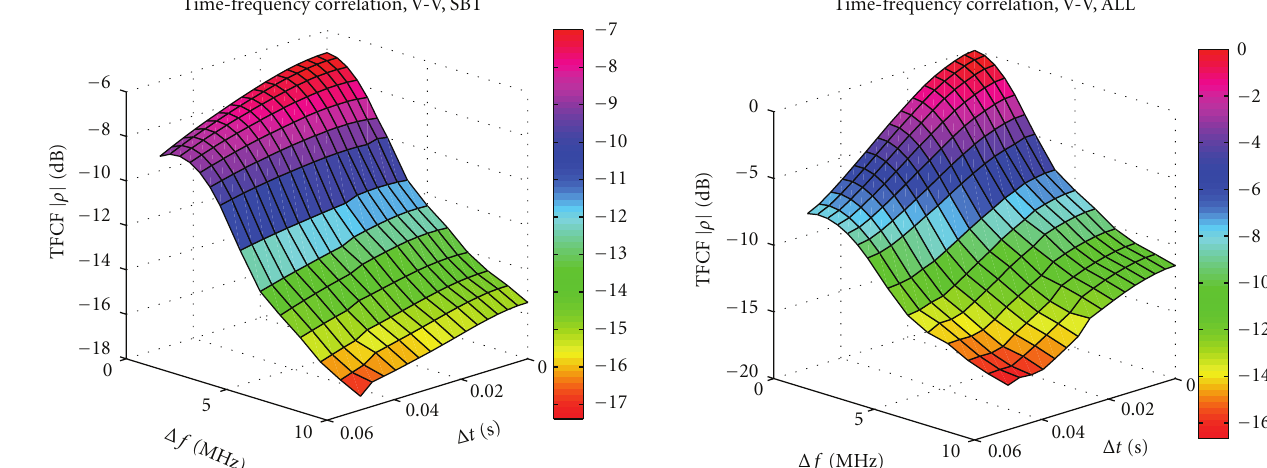
Figure 5: Normalized time-frequency correlation function of V-V link for SBT ray.